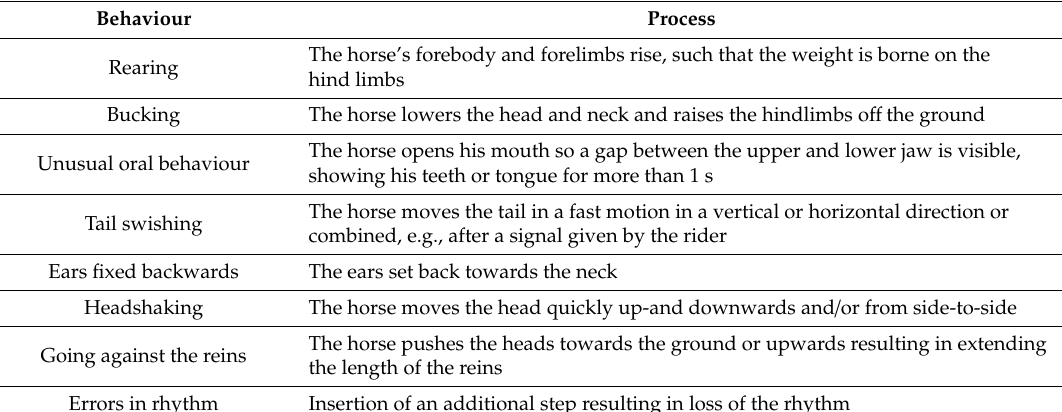
Table 1. Ethogram of conflict behaviour, based on sources: